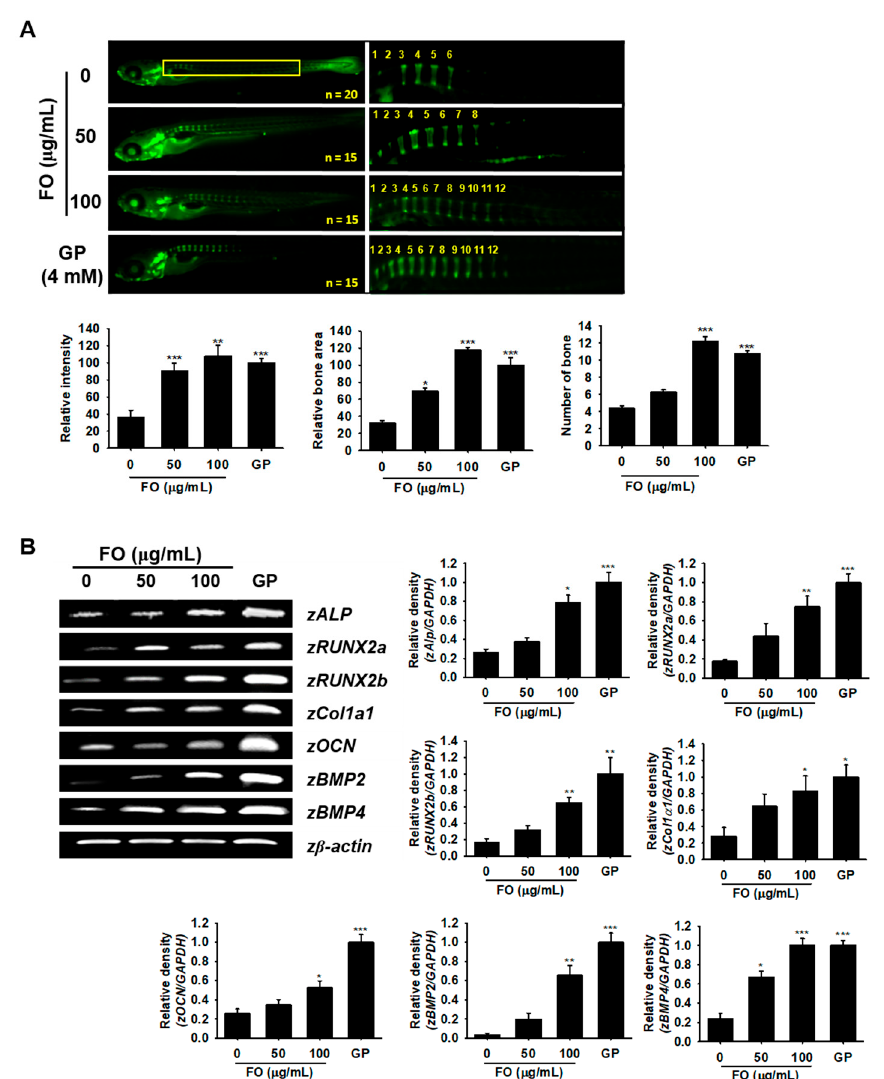
Figure 5. FO promotes vertebrae formation in zebrafish larvae. ( A ) Zebrafish larvae (3 dpf) were treated with FO (50 µ g / mL and 100 µ g / mL) and GP (4 mM) for 6 days (i.e., until 9 dpf) and then stained with calcein to visualize vertebrae formation. Relative intensity of calcein (bottom, left) and relative bone area (bottom, middle) were calculated using the Image J software and normalized against the GP-treated group. The number of vertebrate in each fish was manually counted. All of them are shown in the yellow box. Total fish length is 3.4 ± 0.4 mm. ( B ) Under the same experimental conditions, total mRNA from the 9 dpf zebrafish larvae was subjected to RT-PCR in order to determine zALP , zRUNX2a , zRUNX2b , zCol1a1 , zOCN , zBMP2 , and zBMP4 expression. z β -Actin was used as a house keeping gene. Significant di ff erences among the groups were determined using the one-way ANOVA followed by Bonferroni correction. All data are presented as mean ± SEM (*** p < 0.001, ** p < 0.01, and * p < 0.05 versus untreated group). FO; fermented extract of C. gigas and GP; β - glycerophosphate.